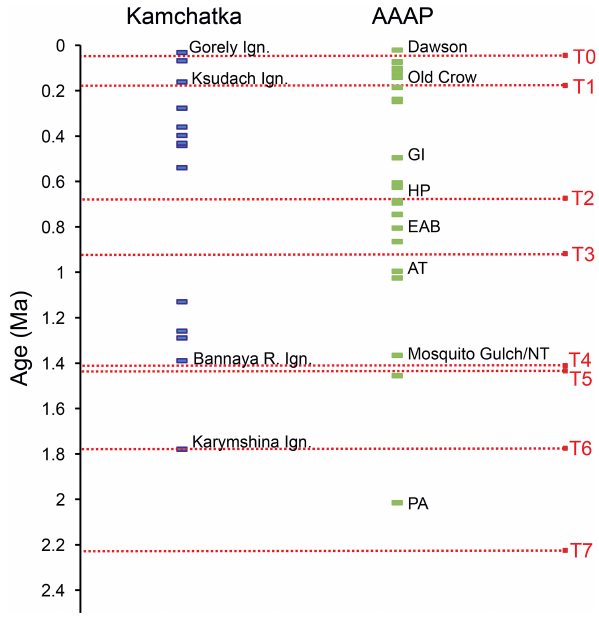
Figure 8. Lake El’gygytgyn tephra ages compared to ages of dated caldera eruptions in Kamchatka and ages of published distal tephra from Aleutian Arc–Alaska Peninsula (AAAP; after Preece et al., 1999; 2011a, b; Westgate et al., 2001, 2011b; Demuro et al., 2008; Bindeman et al., 2010). It is important to note that the frequency of eruptions in Alaska is much greater, but we limited the tephra included in this plot to ones that have been directly